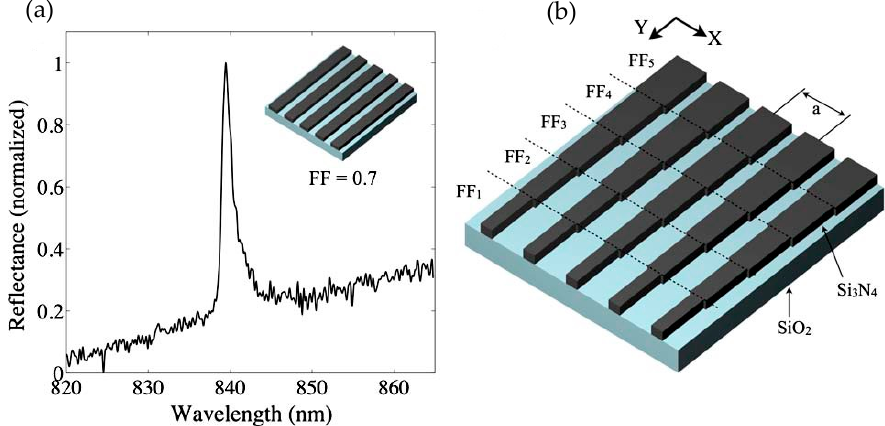
Figure 14. ( a ) Reflectance spectrum of standard rectangular gratings. ( b ) Schematic of chirped gratings. To induce chirping, the fill factor was changed along the Y direction which created a set of rectangular strips each having different fill factors along the Y-direction. Reprinted from [78] under CC BY 4.0.